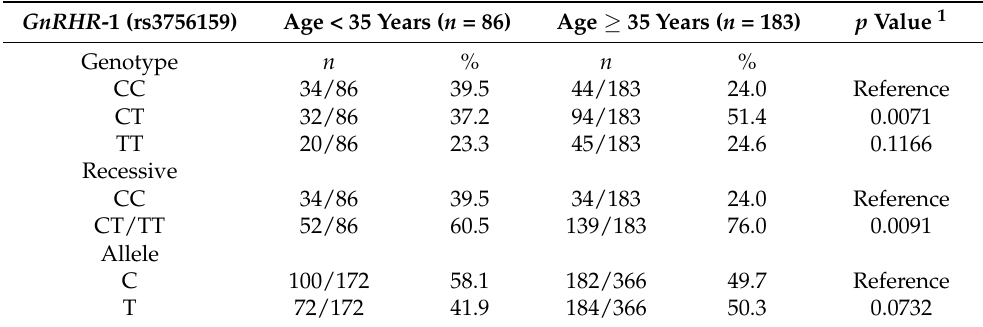
Table 5. The frequencies of GnRHR -1 (rs3756159) SNP among women with serum AMH < 1.2 ng/mL in varied age groups.